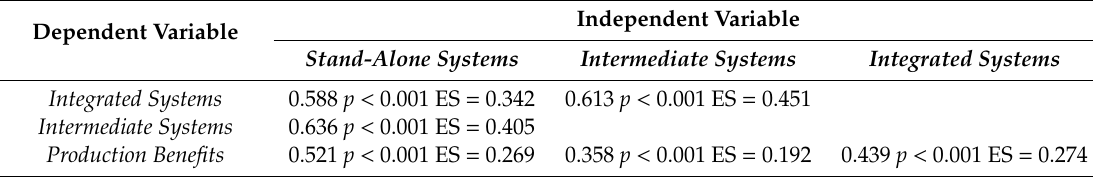
Table 10. Total e ff ects.